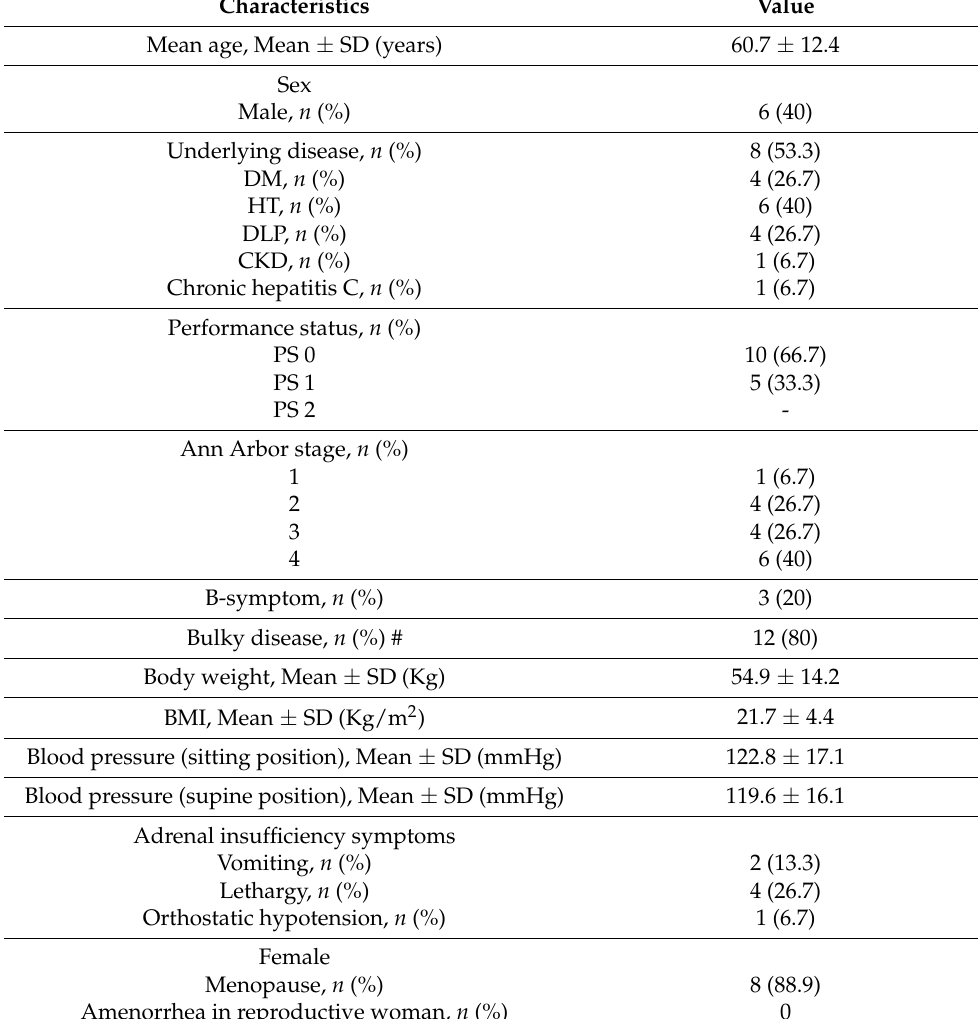
Table 1. Baseline characteristics and laboratory